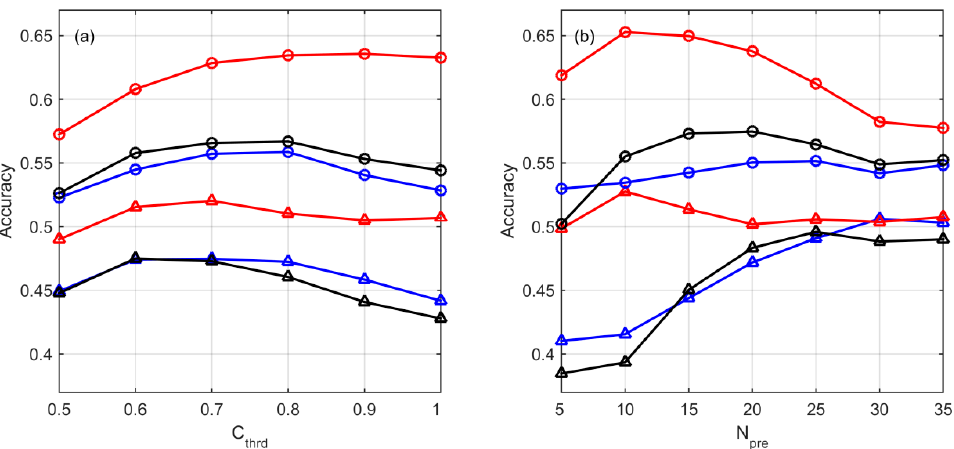
Figure 10. ( a ) The test scores (circle) and average repeated 10-fold CV scores (square) of all N pre s dependent on C thrd s, for the schemes single-MLR (blue), F-ratio (black), and L1 (red). ( b ) The same as ( a ), but for the average scores of C thrd s in the range of 0.5–1 dependent on N pre s.